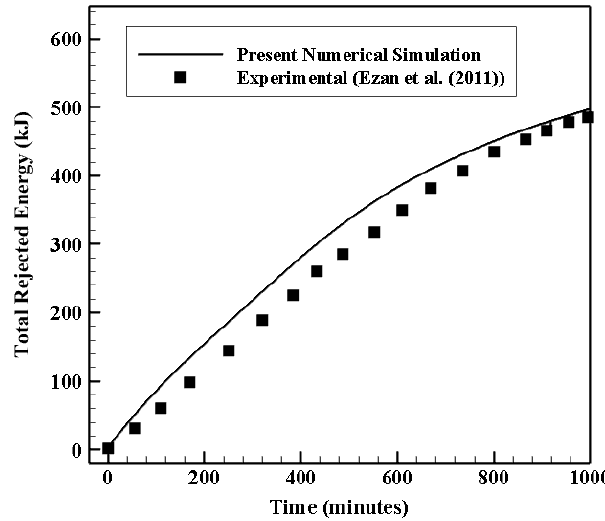
Figure 5. Comparison in terms of total rejected energy between the present study and the experimental work of Ezan et al. [7].